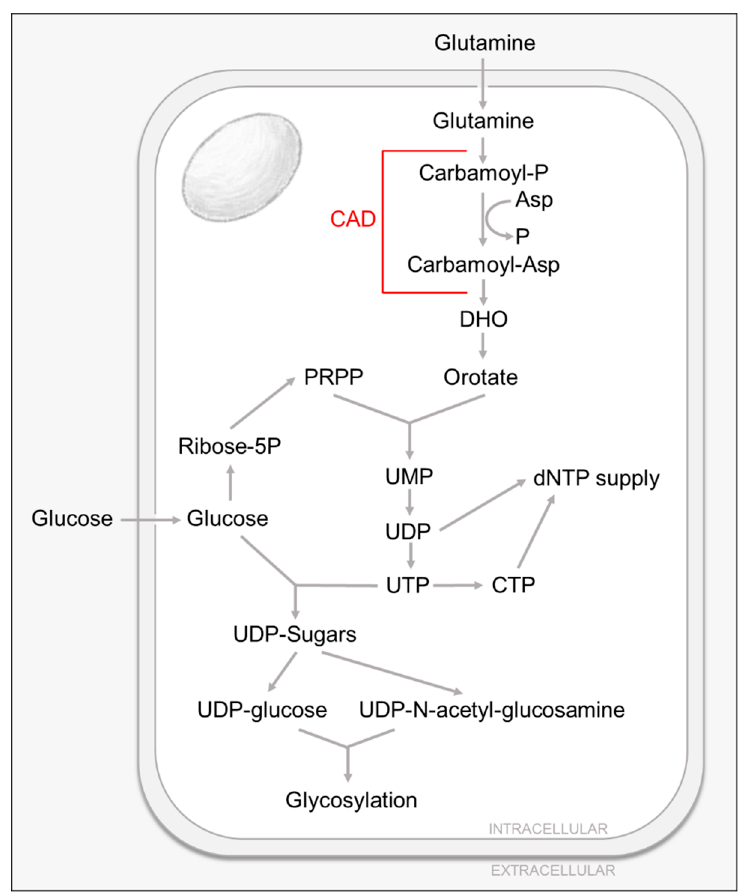
Figure 2. Pyrimidine and Nucleotide Sugar Metabolism.